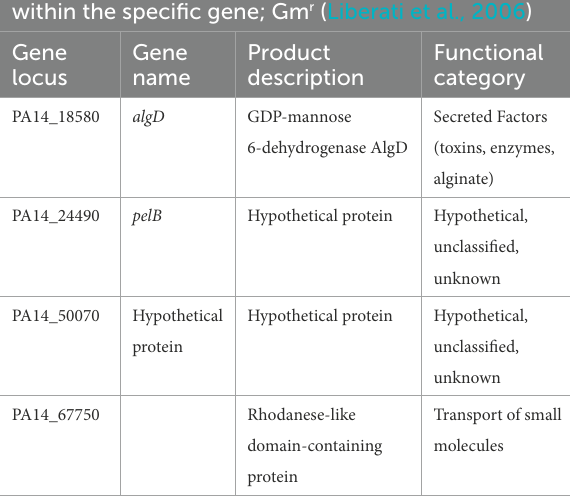
TABLE 1 Mutants selected to assess their role in biofilm formation at the four temperatures. PA14 with MAR2xT7 mariner transposon insertion within the specific gene; Gm r (Liberati et al., 2006) Gene